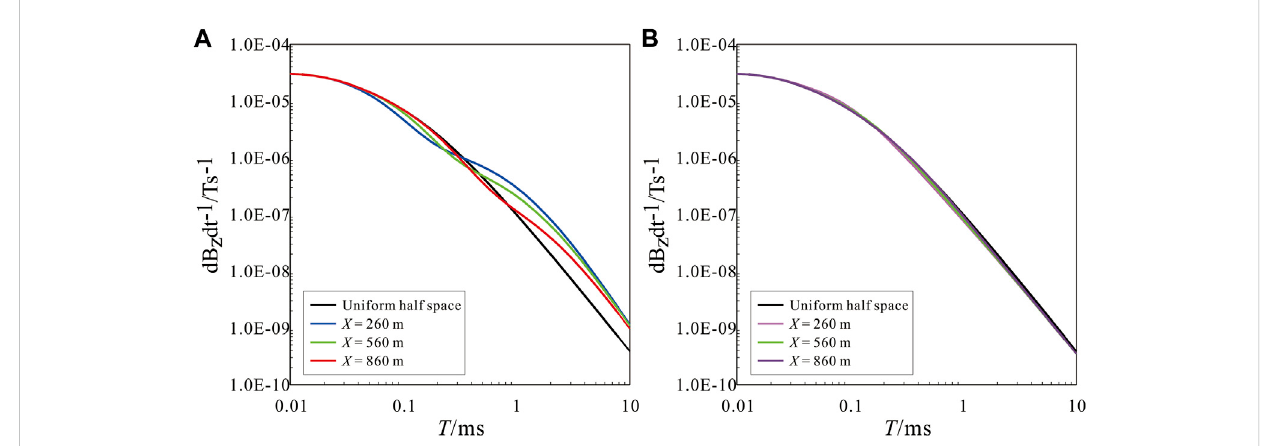
FIGURE 2 Single point decay curves of inclinedstrata models. (A) :H-type model and corresponding uniform half space. (B) : K-type model and corresponding uniform half space.